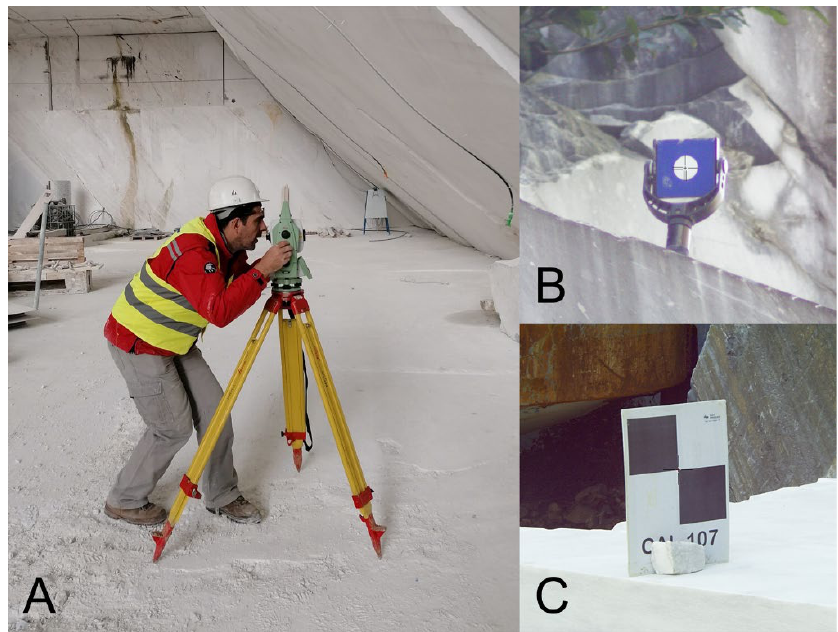
Figure 5. Leica © MS50 Total Station ( A ); detail of a fixed optical target ( B ); removable optical target ( C ).